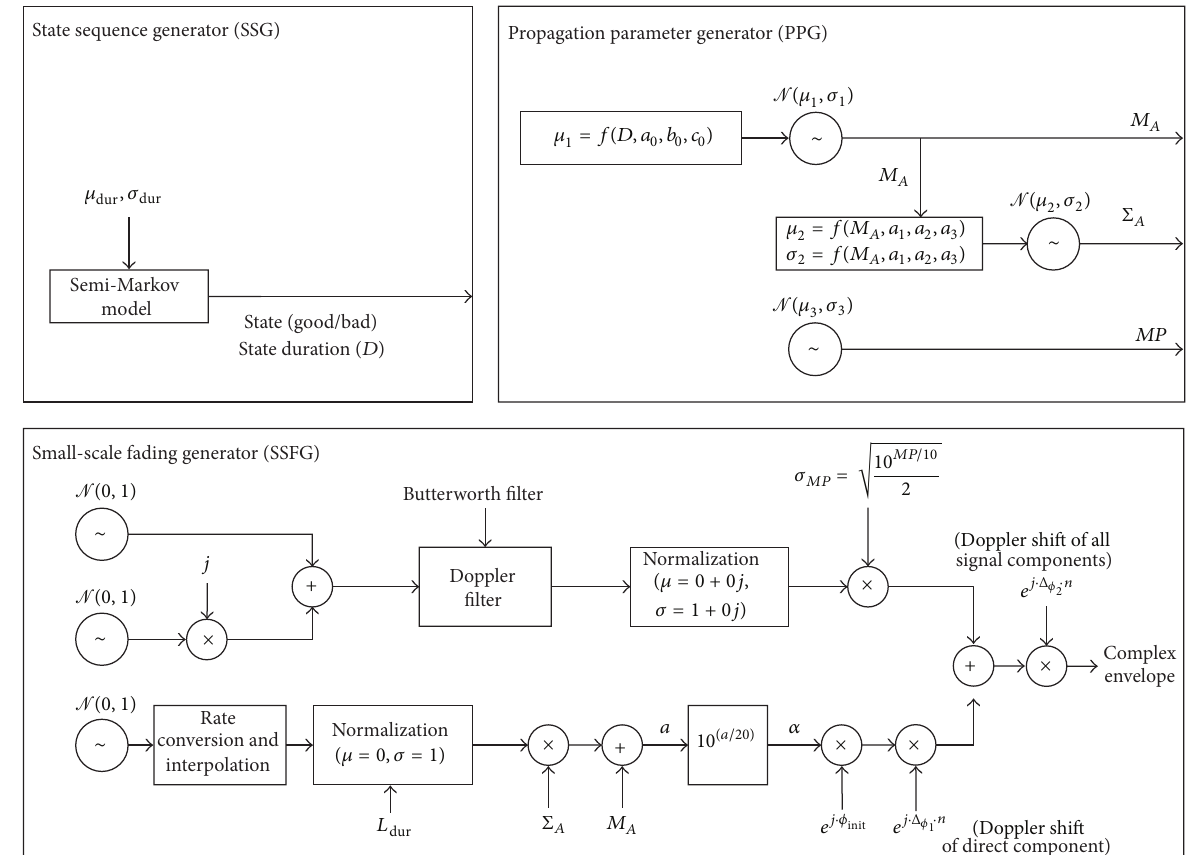
Figure 9: Detailed LMS model implementation diagram comprising the three main elements: state sequence generator (SSG), propagation parameter generator (PPG), and small-scale fading generator